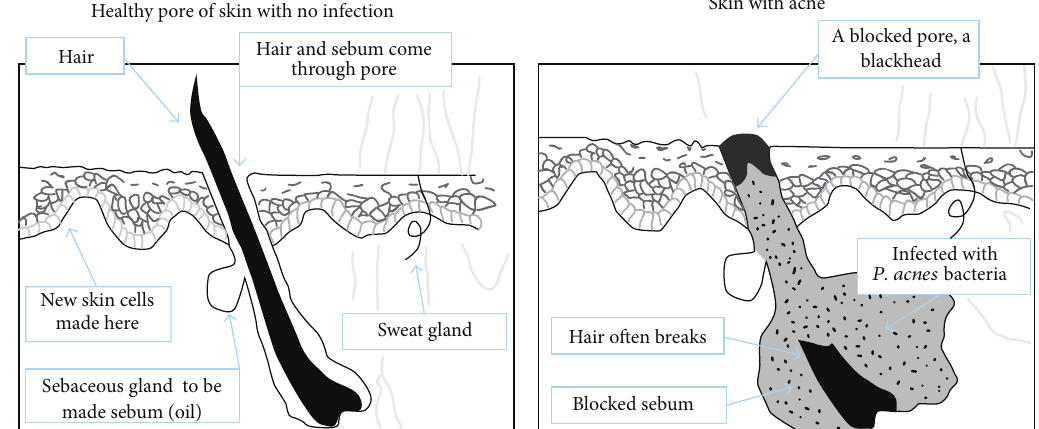
Figure 1: Difference between normal skin and skin with acne.